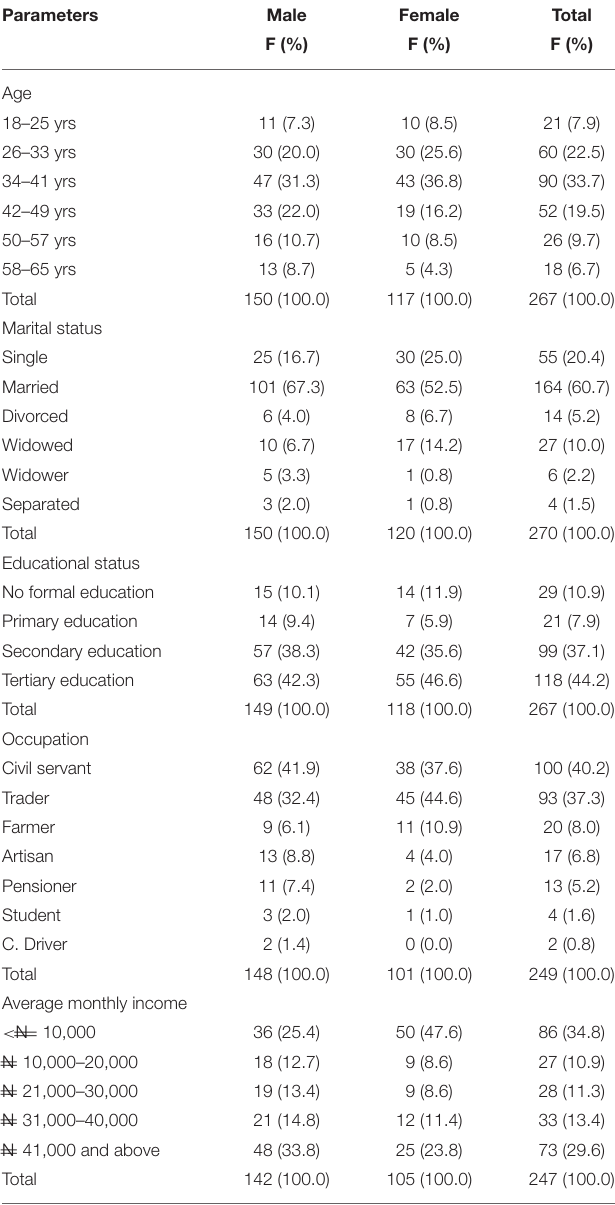
TABLE 1 | Background information and socioeconomic characteristics of the respondents.